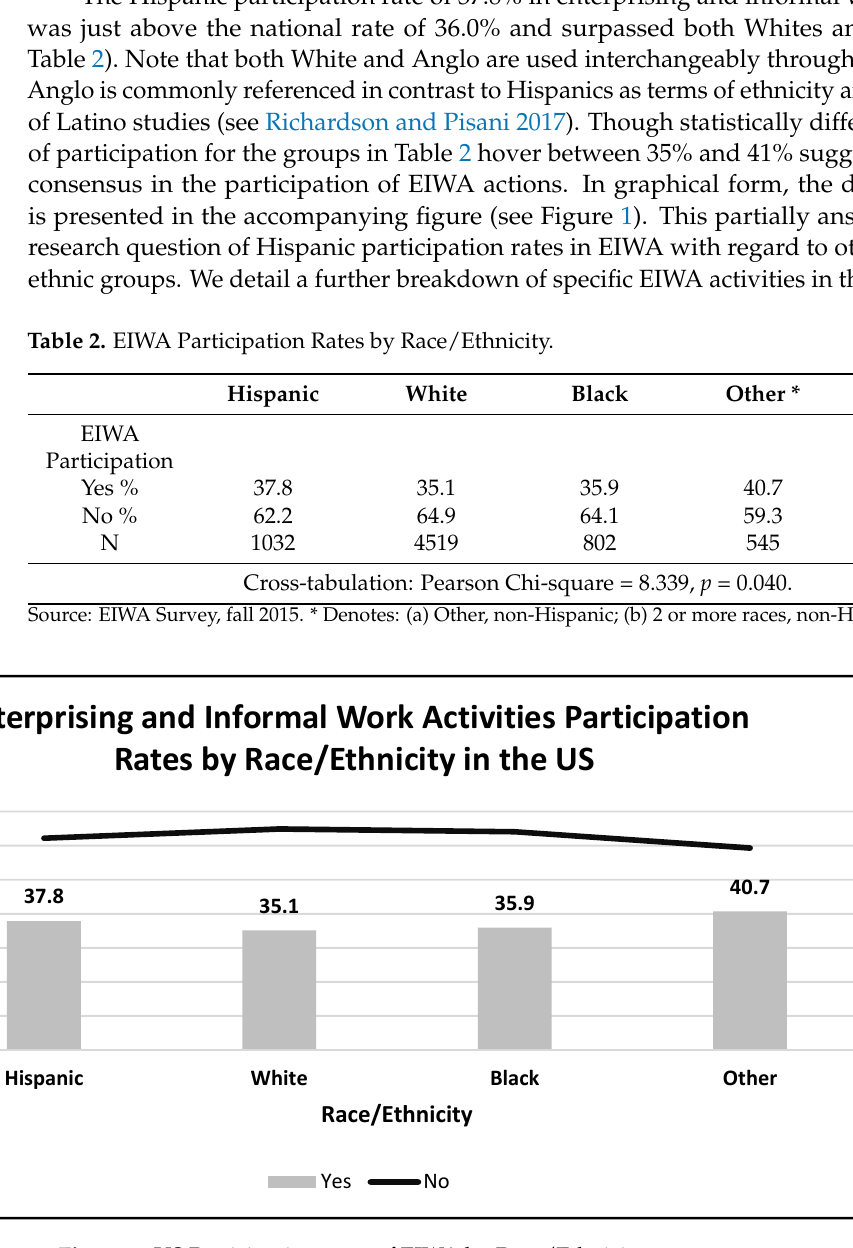
Figure 1. US Participation rates of EIWA by Race/Ethnicity